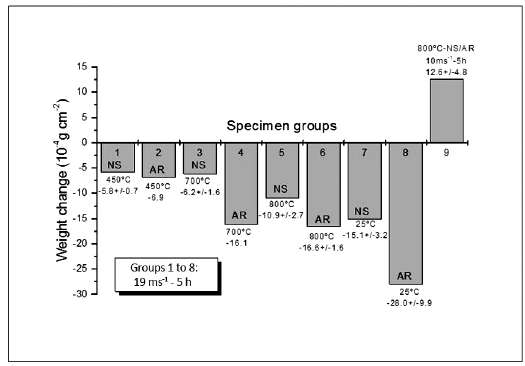
C -25(Ni20Cr) powder (milled 3 2